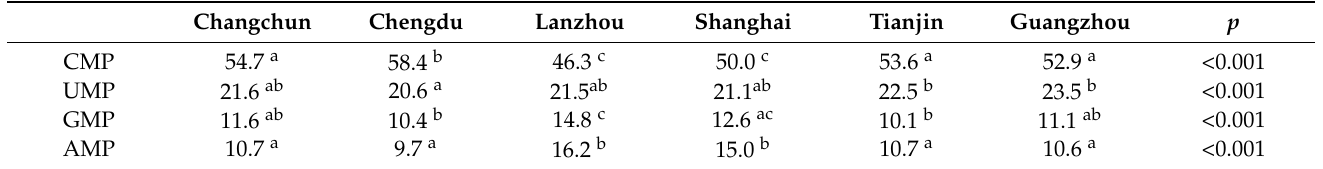
Table 4. Comparison of TPAN compositions in the 6 regions (%).